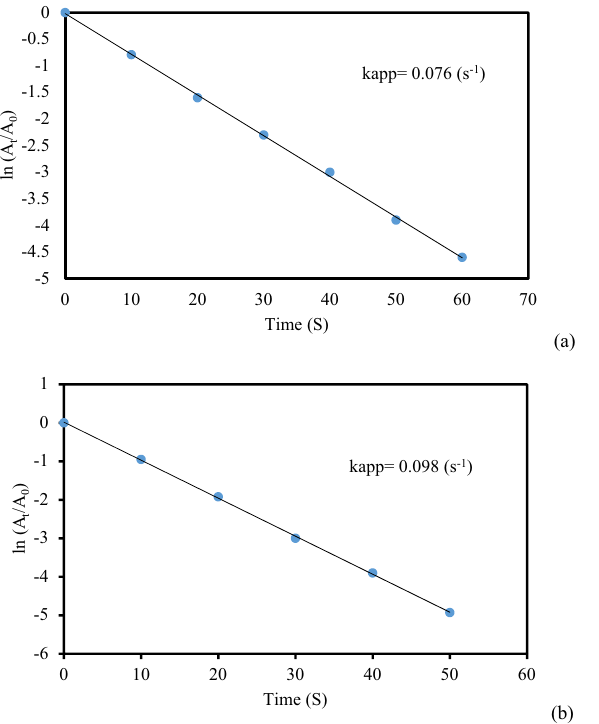
Figure 11. The kinetic plots (lnA t /A 0 vs t) for the reduction of MB using ( a ) 2 mg and ( b ) 3 mg of KIT-5- biguanidine-Au(0) nanocomposite.